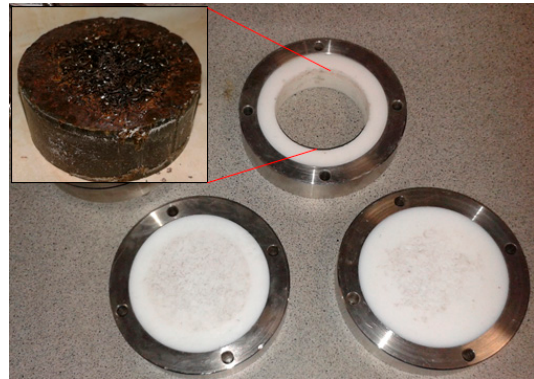
Figure 2. From Batch test #4 (For 1 month duration, sample containing Steel/Mx-80 & distilled water), compacted and heated to 100 °C within a sealed constant volume cell (Ø: 50 mm, h: 20 mm).